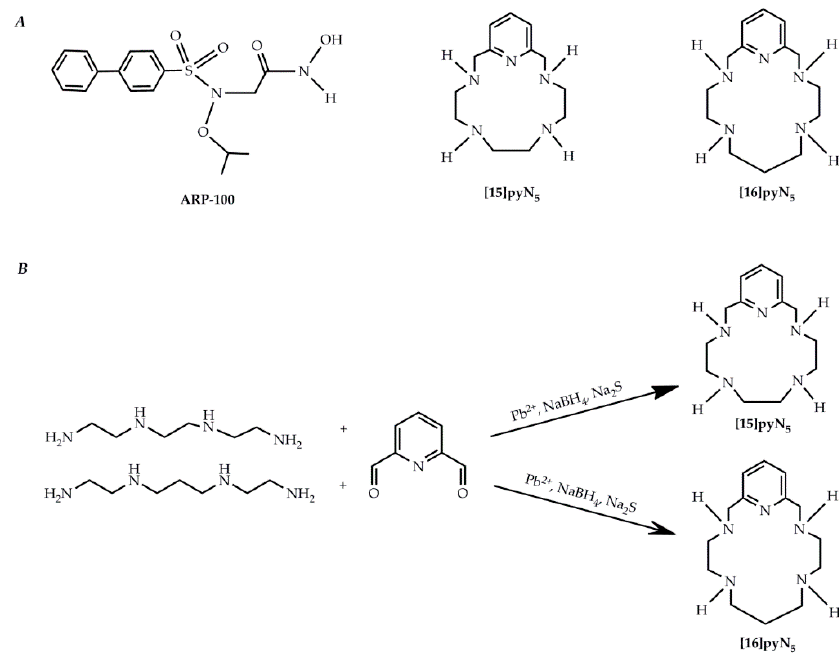
Figure 1. Pyridine containing macrocyclic compounds and ARP100 ( A ) chemical structures; and ( B ) schematic synthesis of [15]pyN 5 and [16]pyN 5 .